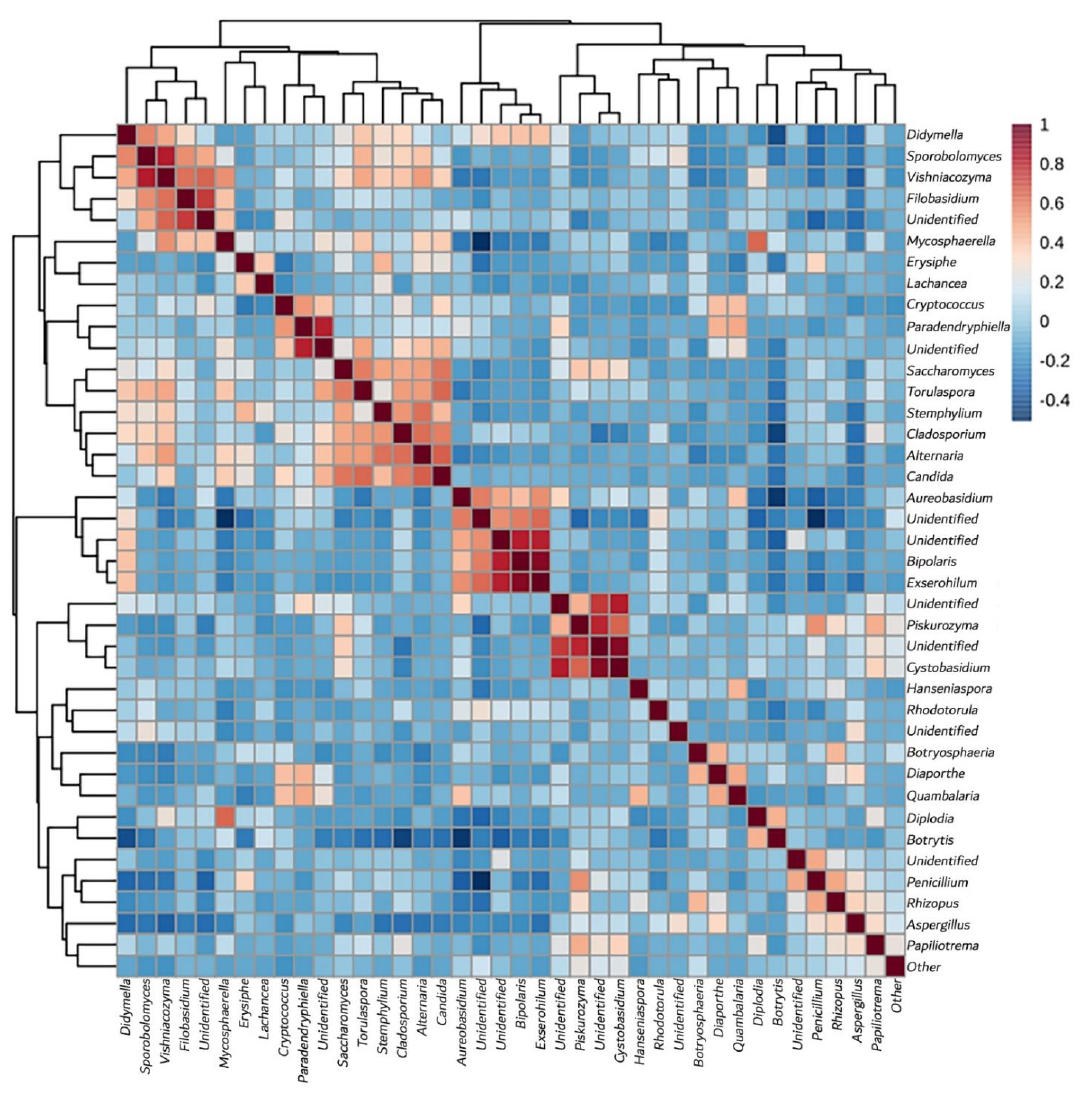
Figure 7. C orrelation analysis for OTU abundances using Pearson ’ s correlation